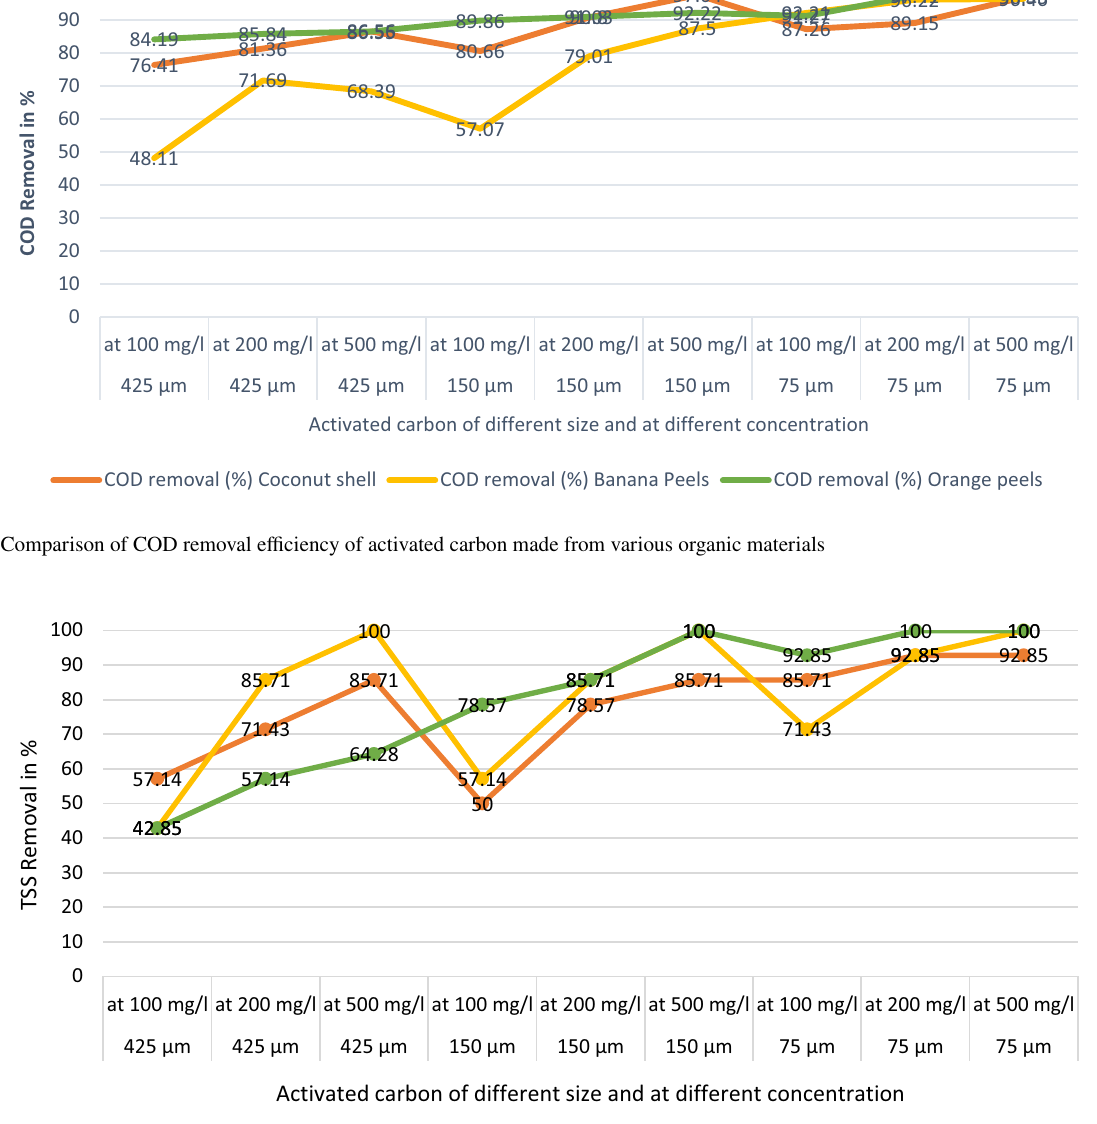
Fig. 11 Comparison of TSS removal efficiency of activated carbon made from various organic